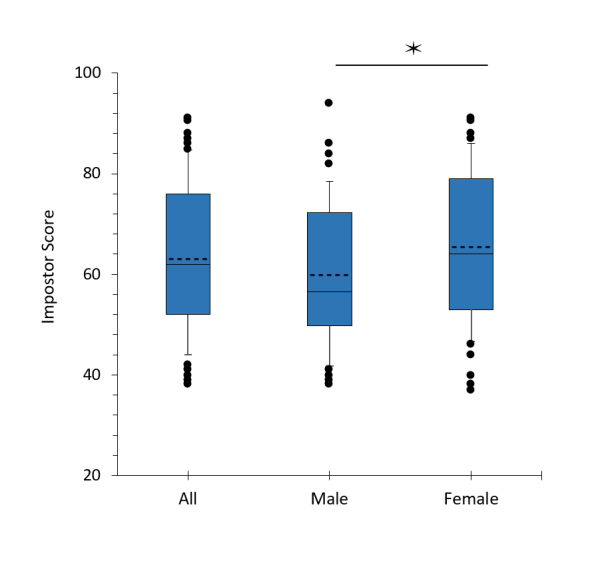
Impostor score in third-year medical students. The mean in the box plot is indicated by the dotted line. N = 112 for all students; 46 for males, 66 for females *p=.46 by Mann-Whitney test (U = 1181).